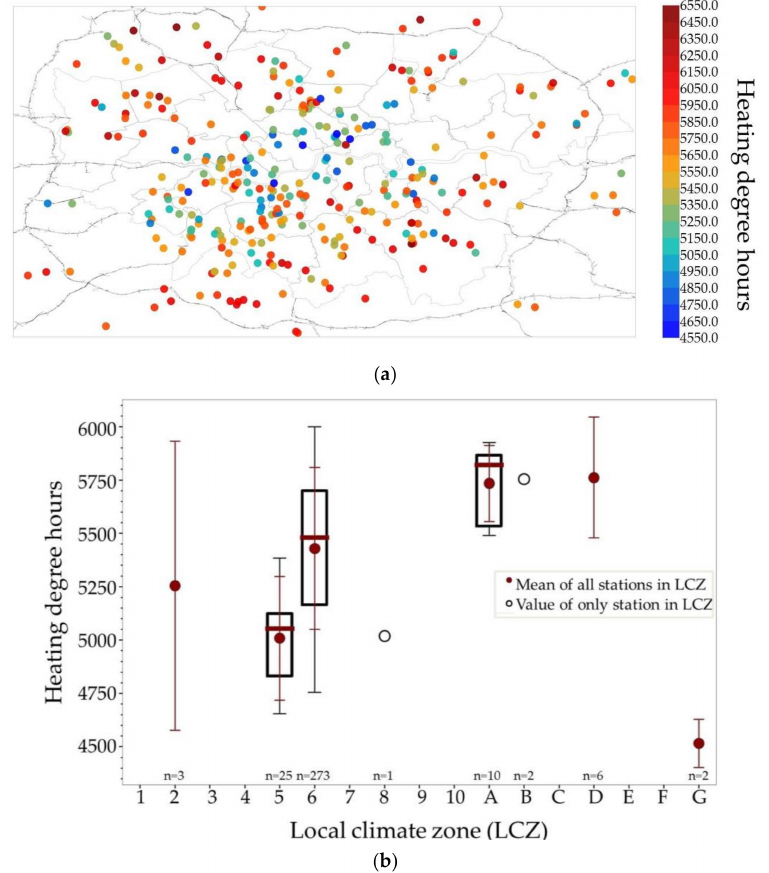
Figure 11. Building heating demand in London in December 2018: ( a ) the spatial distribution of heating degree hours. Red colours indicate greater heating demand than blue colours. ( b ) the mean heating degree hours of each LCZ. Filled red dots represent LCZs with more than one station inside, unfilled dots represent LCZs with only one station inside. Errors on the means are one standard deviation. Boxes are plotted for LCZs with more than ten stations within them. The meaning of the bounds and whiskers of the boxes are explained in Figure